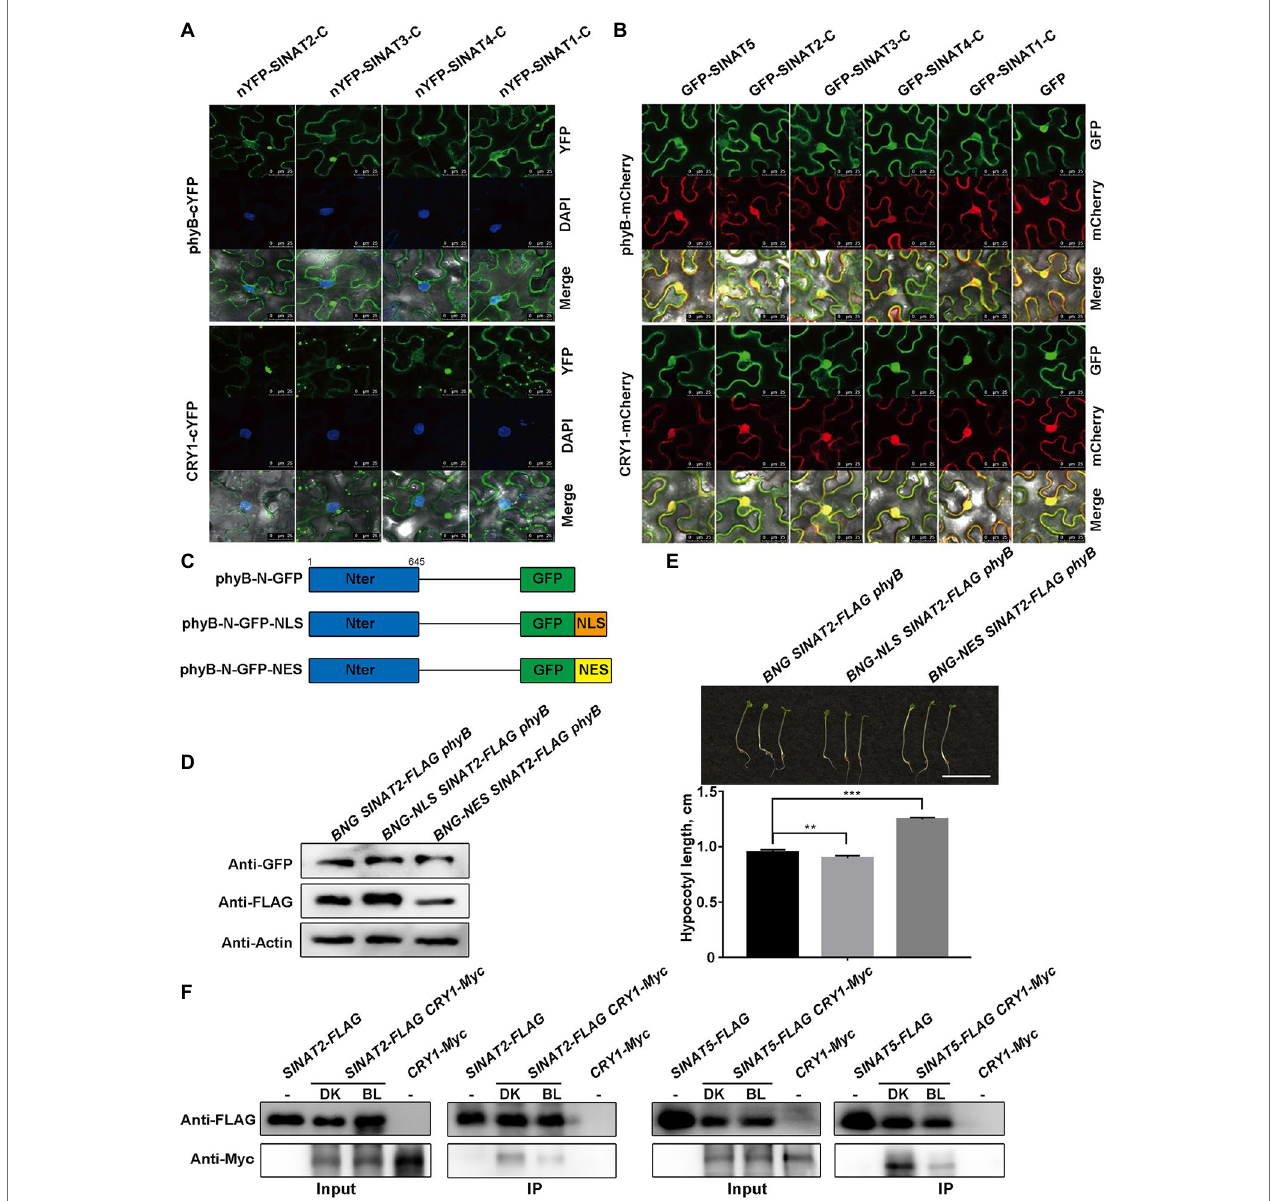
FIGURE 4 | Red light-induced nuclear movement of the phyB and blue light-induced dissociation of CRY1 from SINATs stabilize SINAT protein. (A) The C-terminal SINA domain of SINATs interacts with phyB and CRY1 in the cytoplasm. DAPI was used to stain the nucleus. (B) Co-localization of SINAT-C proteins with phyB- mCherry/CRY1-mCherry in the cytoplasm and the nucleus. (C) Diagrams of the phyB variants. phyB-N was fused to a GFP tag. (D) SINAT2 protein levels in BNG SINAT2-FLAG phyB , BNG-NLS SINAT2-FLAG phyB , and BNG-NES SINAT2-FLAG phyB transgenic plants. An anti-GFP antibody was used to detect the phyB-GFP fusion proteins. An anti-FLAG antibody was used to detect SINAT2-FLAG. (E) Hypocotyl phenotype and length of BNG SINAT2-FLAG phyB , BNG-NLS SINAT2- FLAG phyB , and BNG-NES SINAT2-FLAG phyB lines. Error bars indicate the SE ( n = 30). Statistical significance was determined by Student’s t -test. ** p < 0.01 and *** p < 0.001. (F) Co-IP assays showing blue light promote the dissociation of CRY1 from